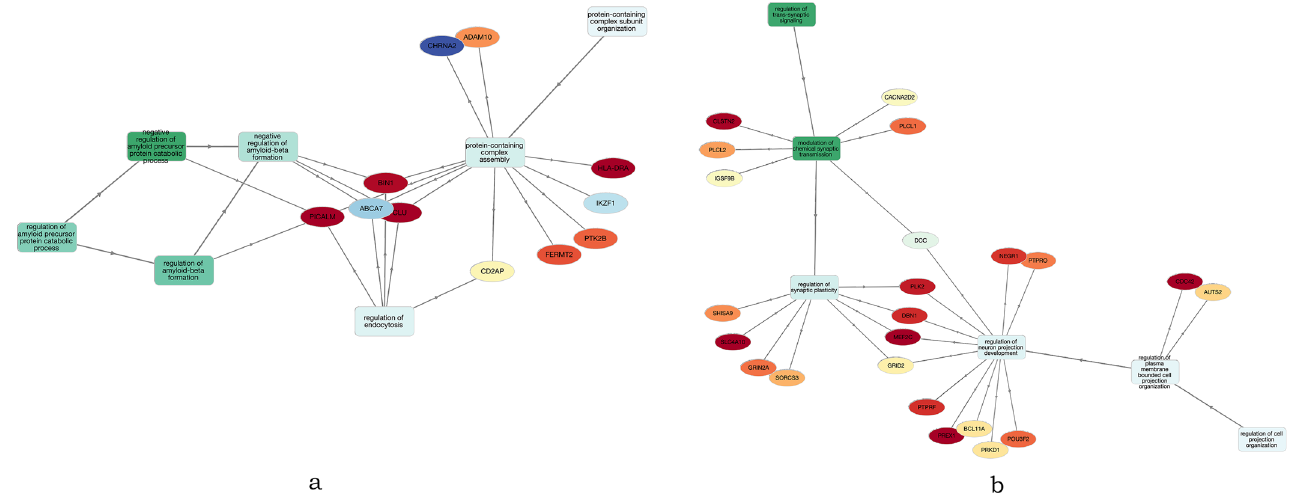
Figure 5. Gene ontology term enrichment of genes of the variants involved in ( a ) PRS-Alz 5 and ( b ) PGS-Int 7 for biological process category. Oval shaped boxes represent the protein-coding genes and the rectangular boxes define the GO term for the biological category. The oval boxes are coloured based on protein expression in the cerebral cortex as per the Human protein Atlas